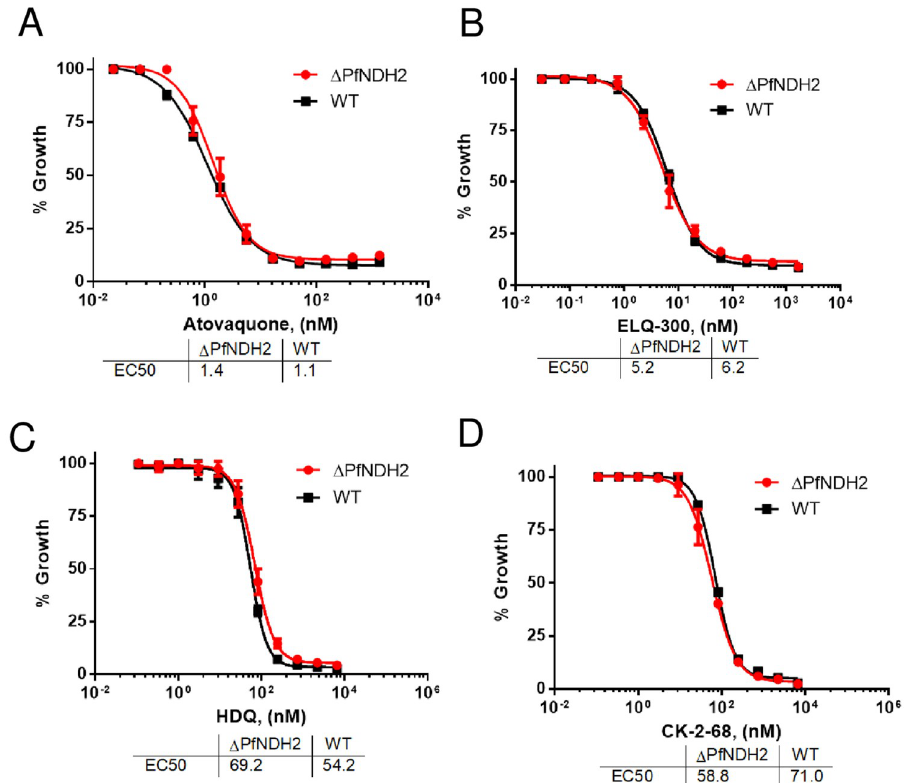
Fig 2. Deletion of PfNDH2 does not affect sensitivity to mitochondrial electron transport chain inhibitors. 3 H- hypoxanthine incorporation assays were performed in the Δ PfNDH2 and WT parasites challenged with atovaquone (A), ELQ-300 (B), HDQ (C) and CK-2-68 (D). For each compound in each parasite line, a mean EC 50 value of replicated experiments is shown at the bottom of each panel. Data shown is a representative of n � 3 replicates. Error bars indicate standard deviations of three technical replicates in the representative assay.